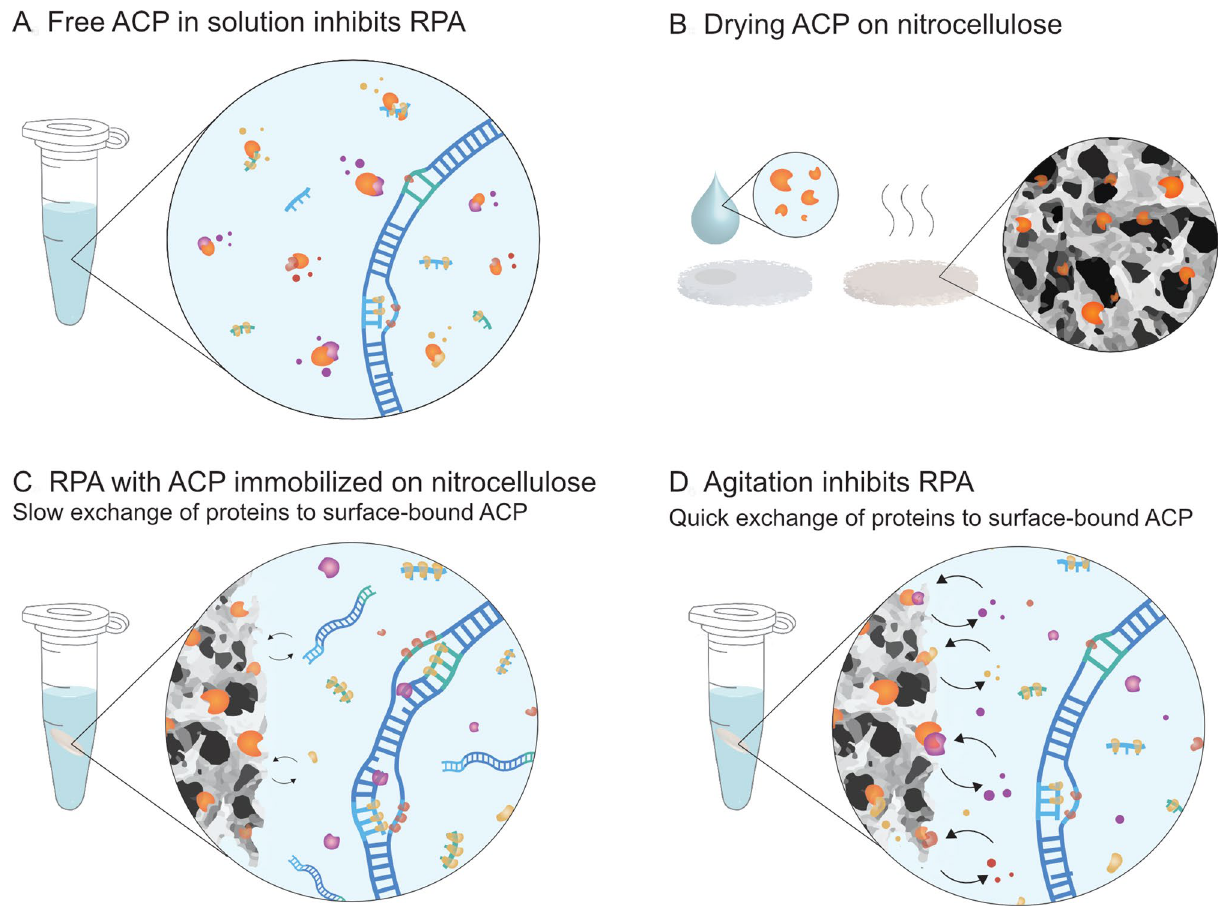
Figure 1. Schematic representation of the concepts. ( A ) Free ACP in solution inhibits RPA possibly by digesting the enzymes necessary for amplification; ( B ) drying ACP on nitrocellulose for immobilization. ( C ) Undisturbed ACP immobilized on nitrocellulose does not immediately inhibit RPA. ( D ) Agitation probably increases the rate at which RPA reagents come in contact with active ACP on the surface of